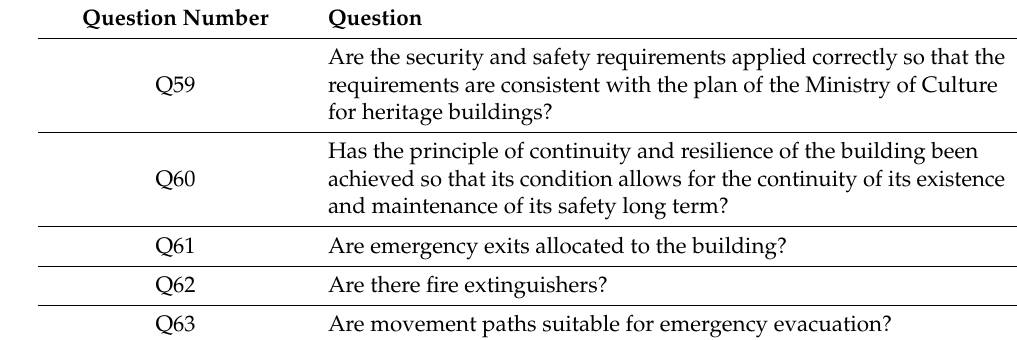
Table 12. Security and safety questions.